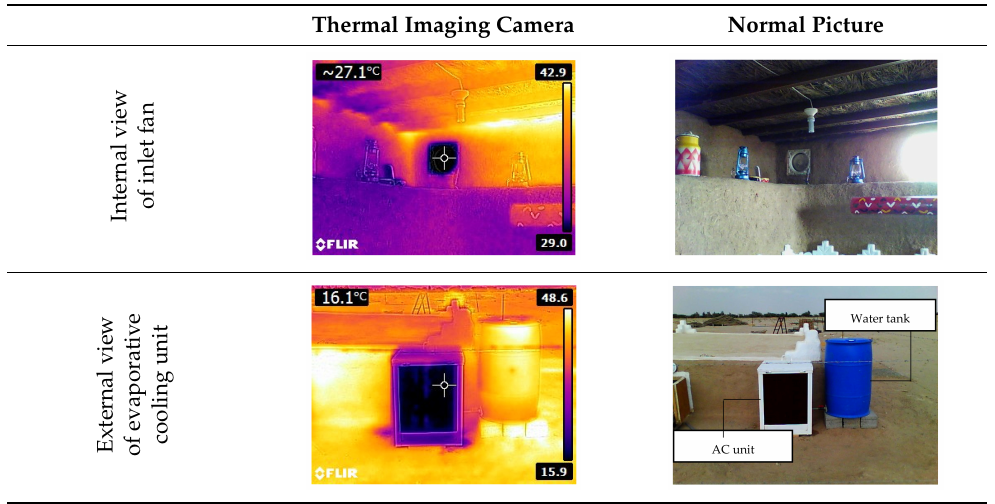
Figure 6. On-site building of evaporative cooling unit with internal fan installed to pull in air from external unit into inside the room. Table 1. Inner surface temperatures of water tank and internal